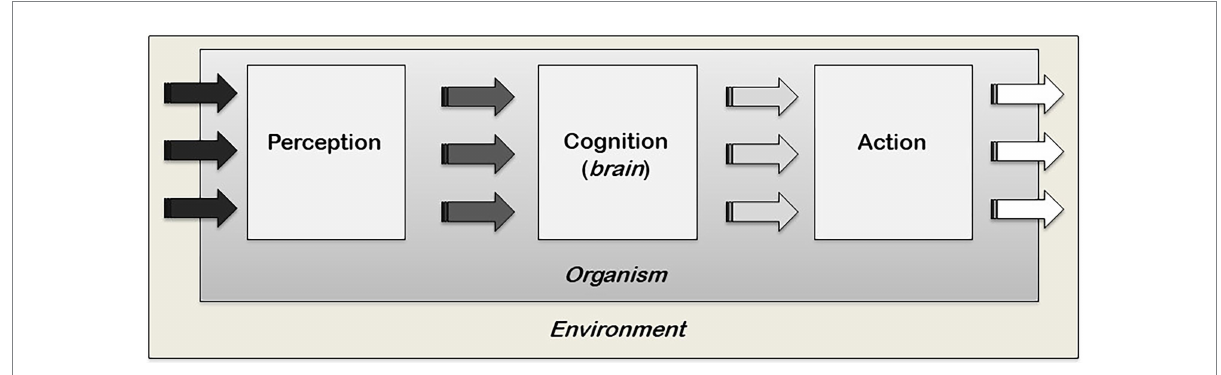
FIGURE 1 A cognitivist modular and linear view of cognition. Perception builds a discrete and abstract representation of the local environment which is, in turn, transformed by the cognitive processes of the brain into actions. Within this model, decision-making resides and is confined within the middle box of the brain. This model is also known as the ‘Classic Sandwich Model’ where the outer slices of perception and action are peripheral to the inner filling of cognition and separate from one another. They are also separate from cognition, which interfaces between perception and action (adapted from Burr,